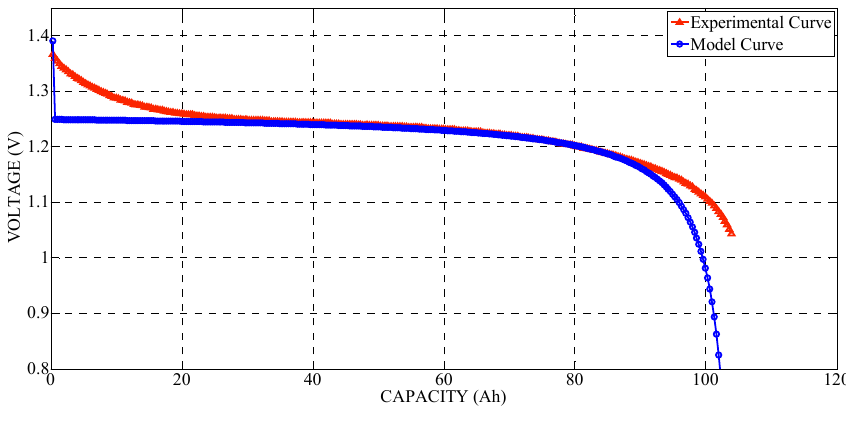
Figure 18. Discharge curve (0.2 C).